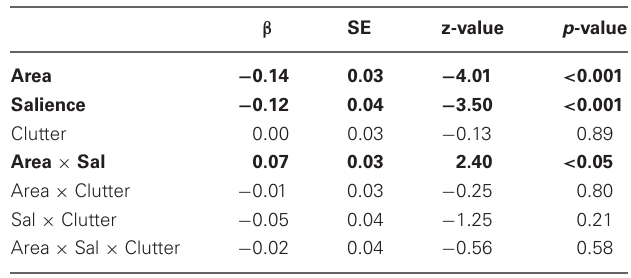
Table 3 | Results of mixed-effects model for predicting number of landmarks included in a